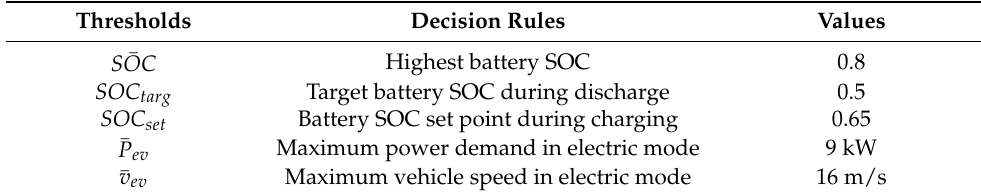
Table 2. Thresholds of the heuristic